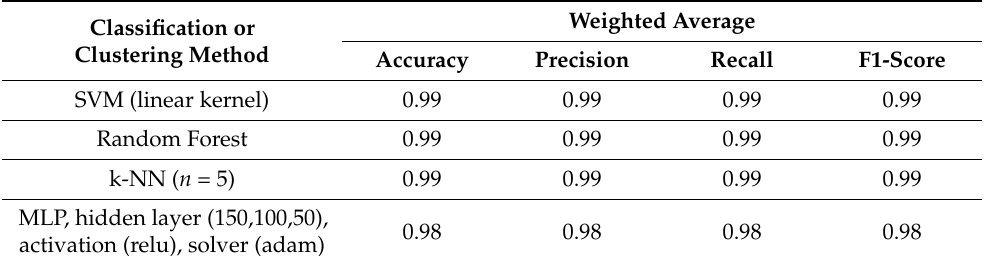
Table 8. Performance of different classification method using 2 features (RSSI_WSN and